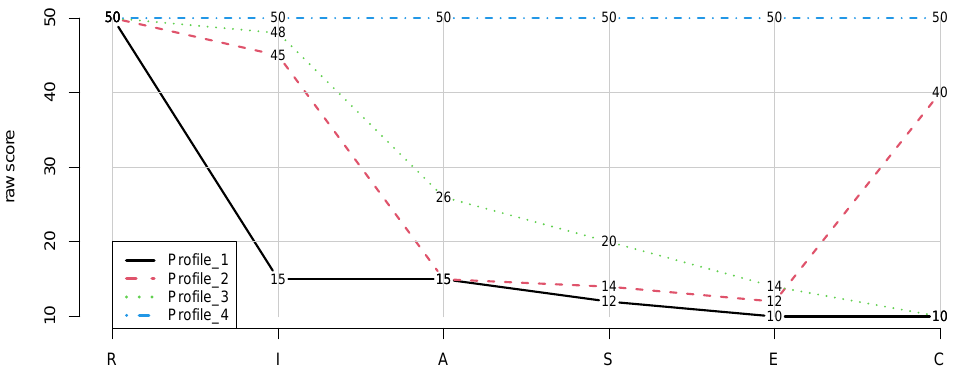
Figure 3. Lineplots for four different RIASEC raw score profiles.